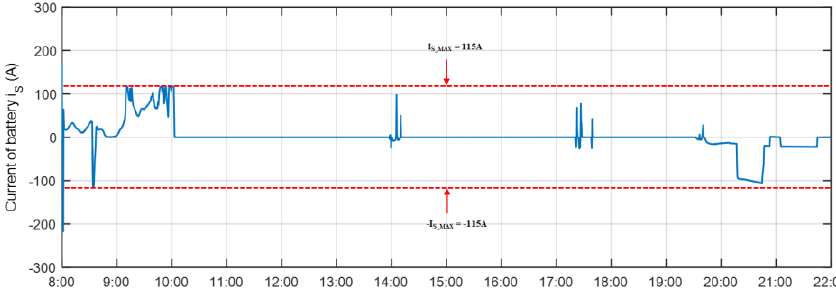
Figure 23. Storage current evolution under SPVA.